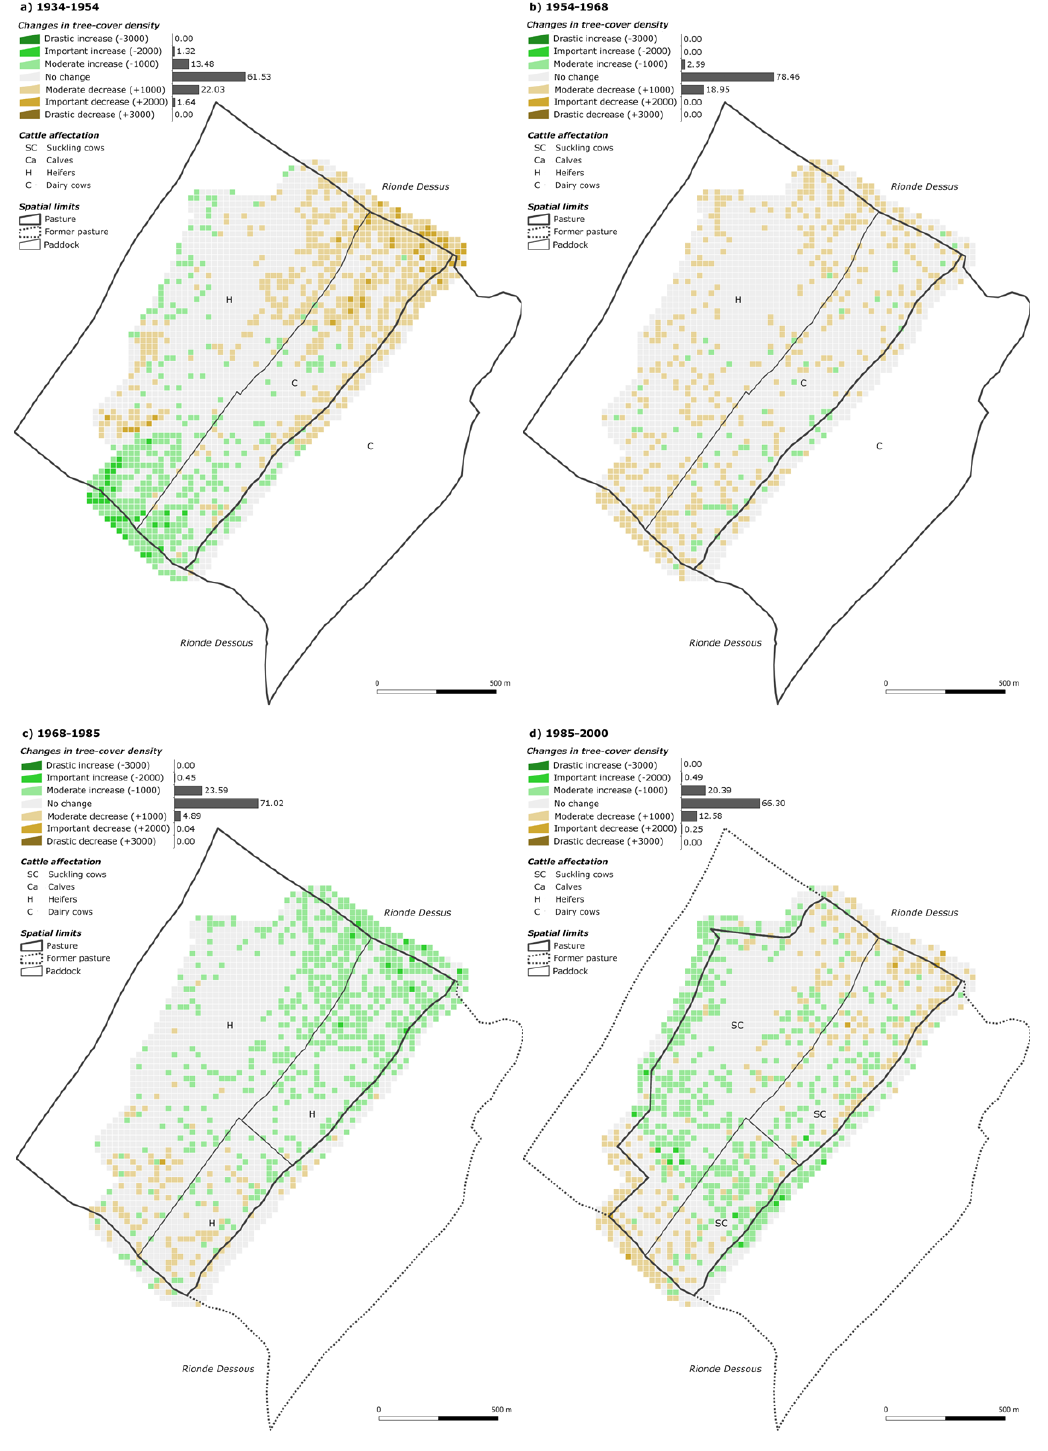
Fig. 7 . Evolution in management structures and in tree-cover categories between 1934 and 2000 in